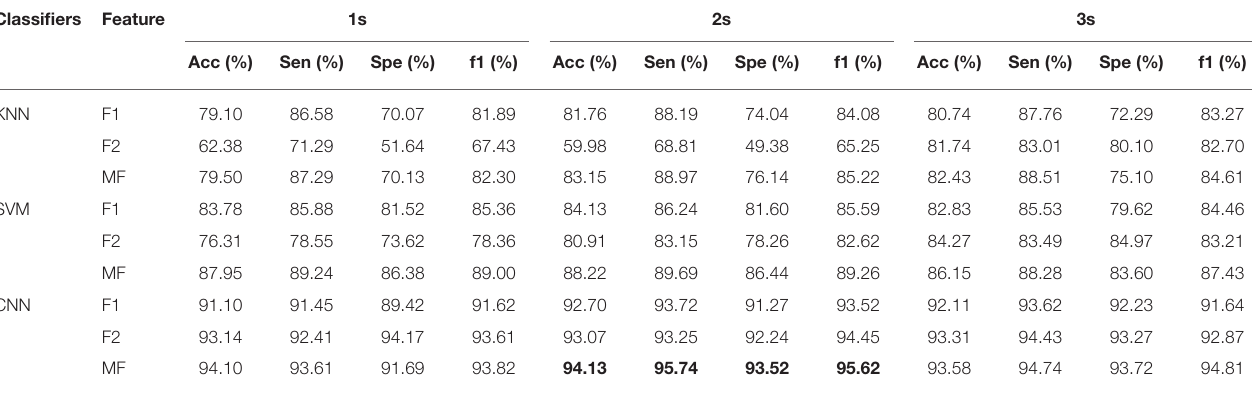
TABLE 3 | Classification results of the EEG signals from all classifiers. Classifiers